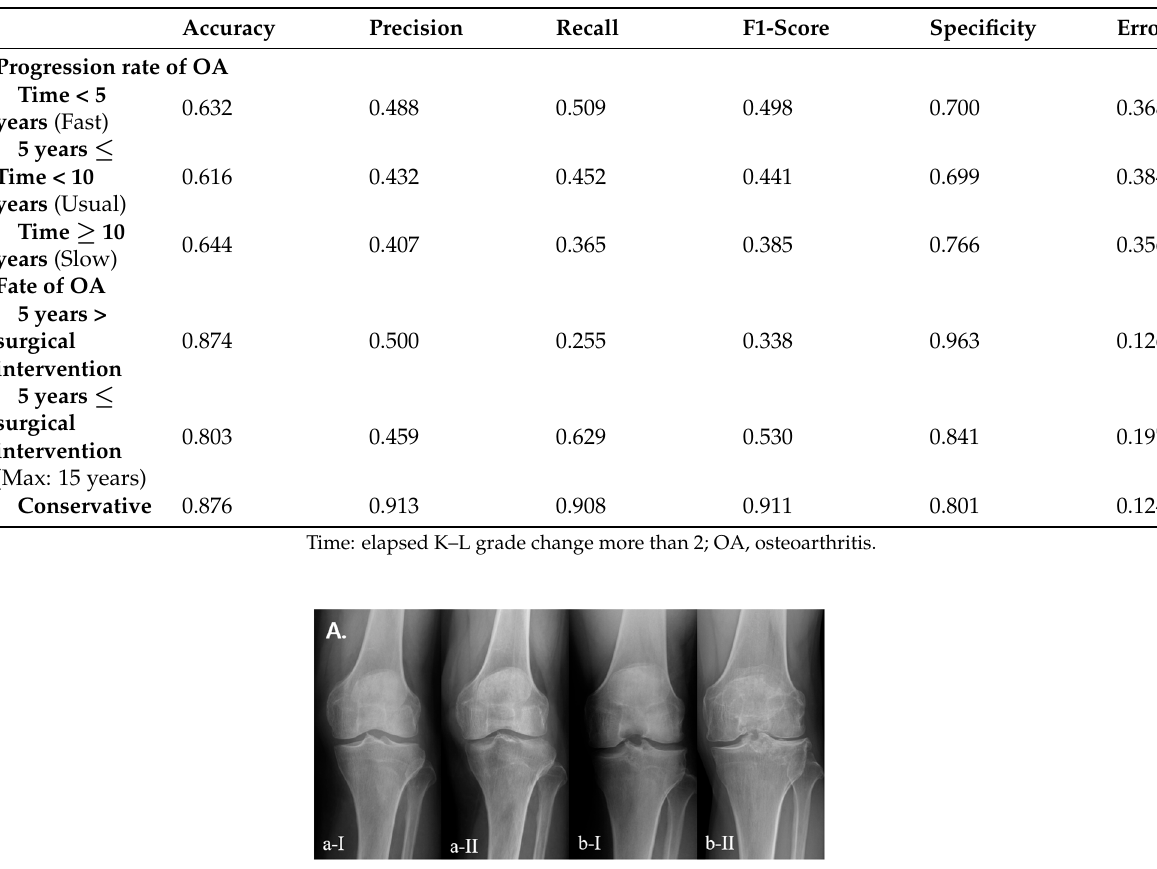
Table 4. Performance of model.